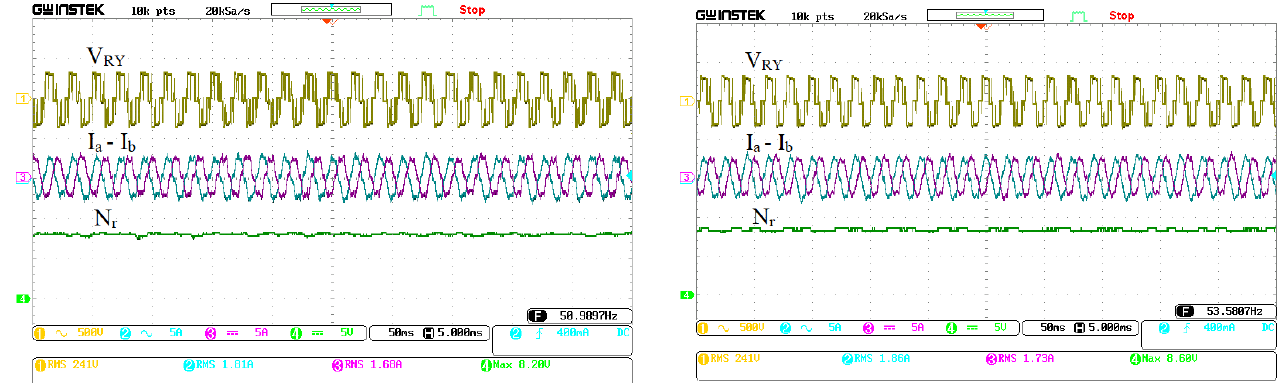
Figure 15. Zoomed waveforms during the variation of speed.